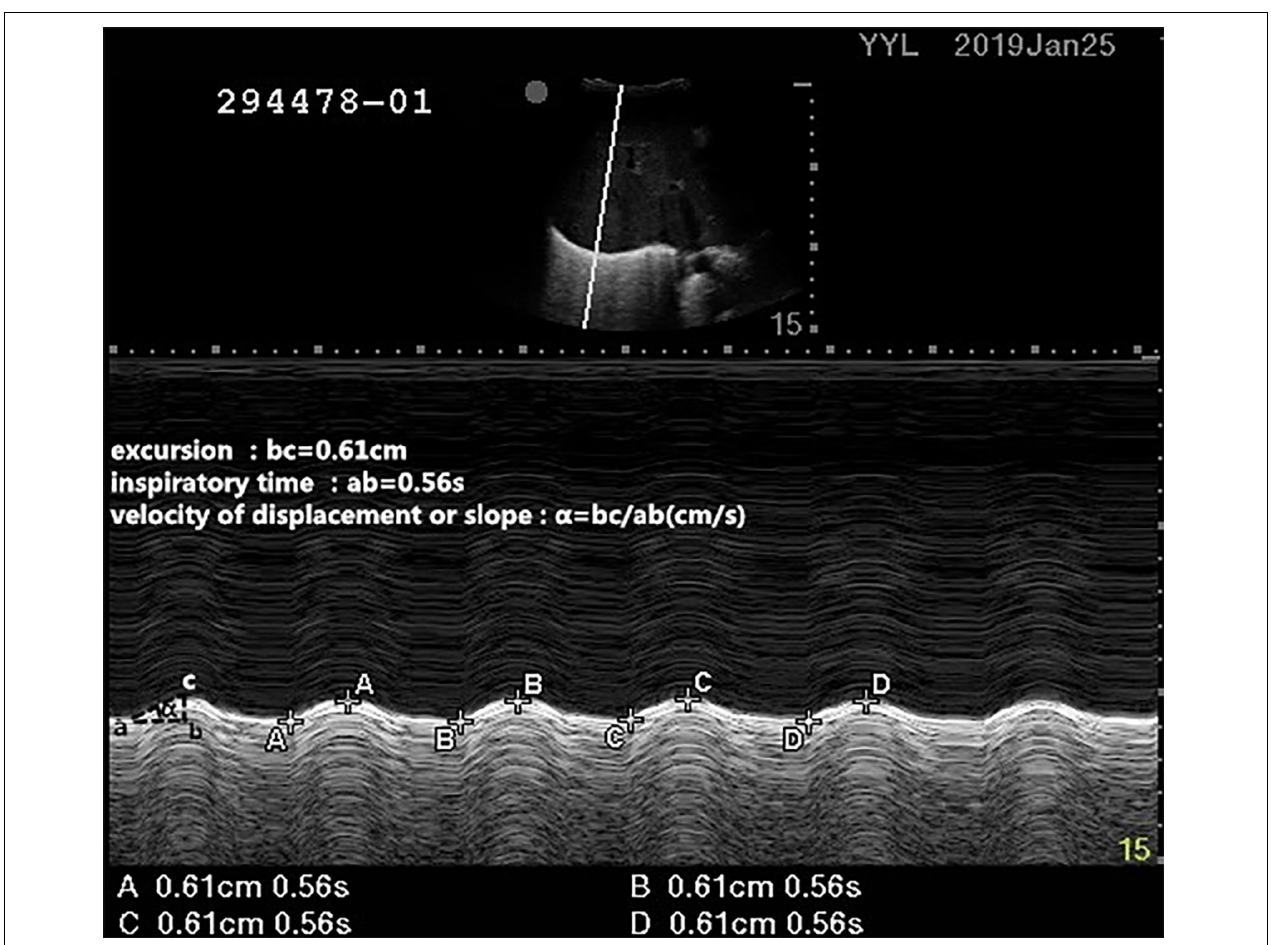
FIGURE 1 | Measurements of the diaphragmatic excursion (DE) and systolic velocity by the ultrasound. During inspiration, the diaphragm contracts and moves toward the probe. During expiration, the diaphragm rebounds and moves away from the probe. The distance between them on the vertical axis during a respiratory cycle was recorded as the diaphragmatic excursion. For systolic velocity, it was equivalent to DE/time of inspiratory